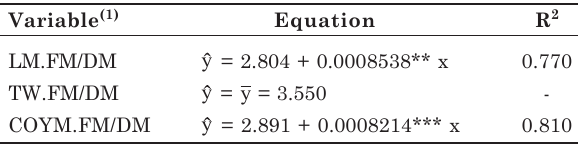
(1) Leaf (LM), commercial yerba mate (COYM) and twigs (TW). ** and *** significant at 1 and 0.1 %,